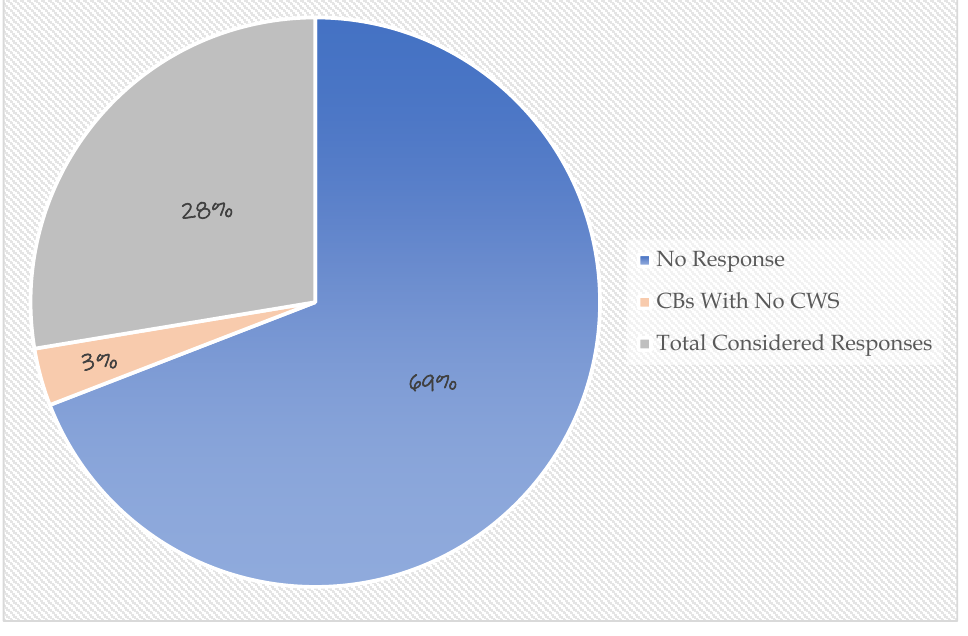
Figure 4. Survey responses.